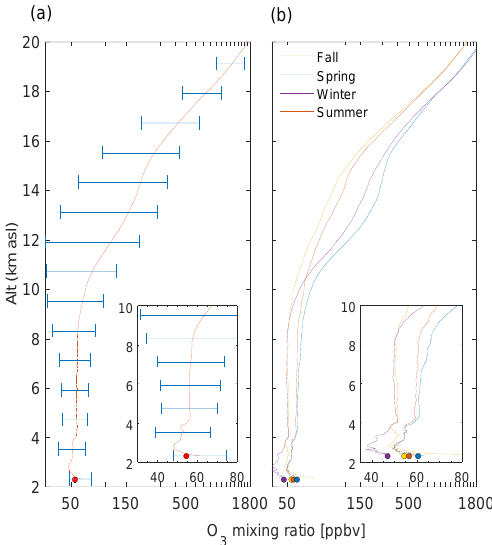
Figure 3. (a) Ozone mixing ratio climatological average (2000– 2015) computed from the TMF lidar measurements (red curve). The cyan horizontal bars indicate the standard deviation at intervals of 1km. The red dot at the bottom indicates the mean surface ozone mixing ratio (2013–2015) measured simultaneously with lidar. A zoomed version of the plot focused on the tropospheric part of the profiles (2–10km) is inserted within the figure. (b) Seasonally aver- aged ozone mixing ratio profiles for spring (MAM), summer (JJA), fall (SON) and winter (DJF). The dots at the bottom indicate the corresponding surface ozone seasonal averages. A zoomed version of the plot focused on the tropospheric part of the profiles (2–10km) is inserted within the